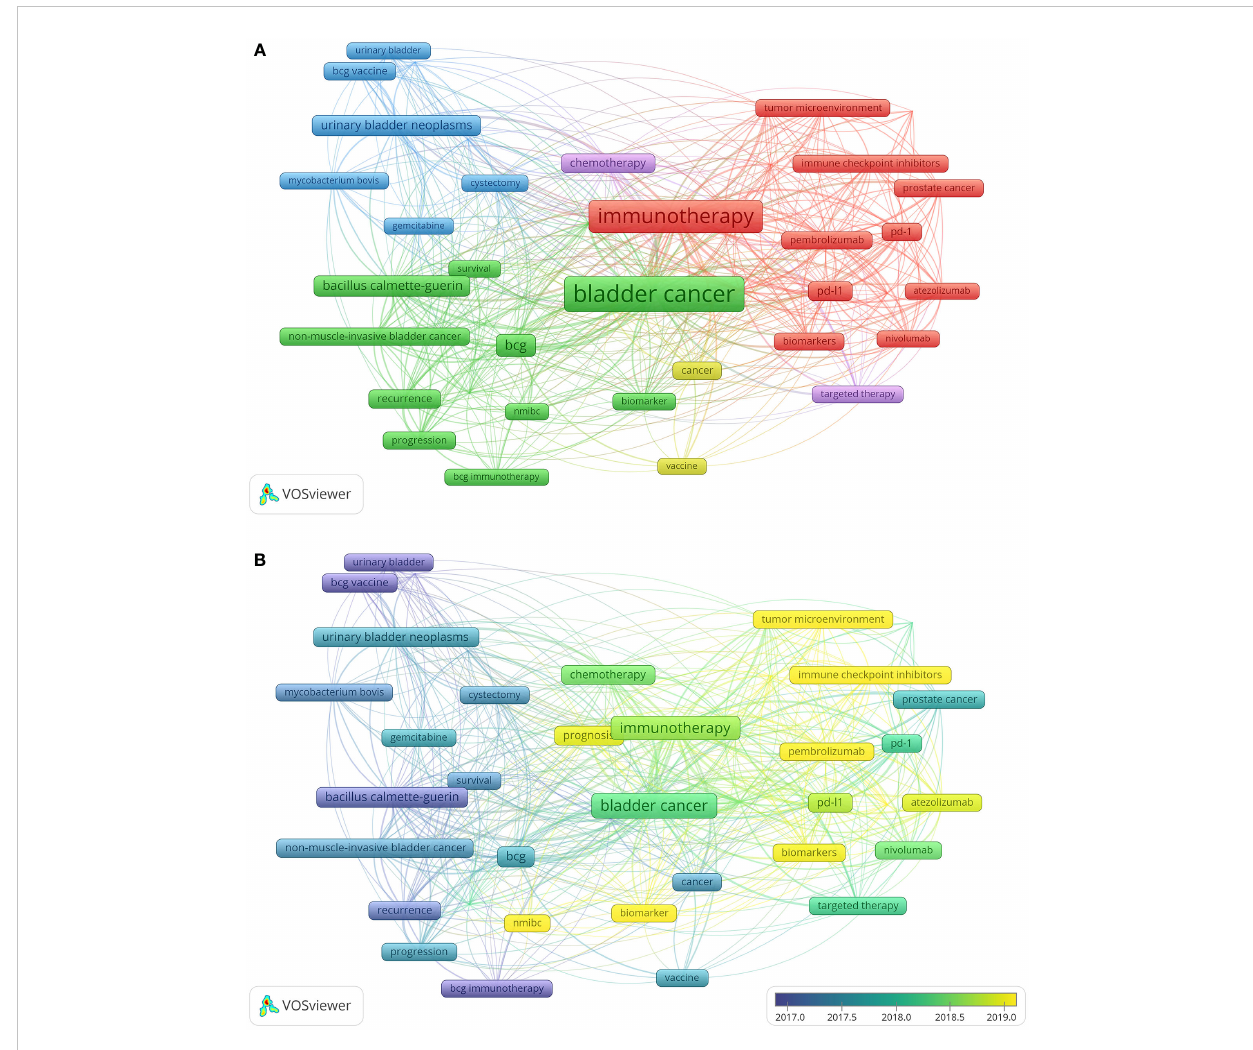
FIGURE 4 Visual map of the co-occurrence of keywords. (A) Keywords clustering chart. Each term ’ s node size is proportional to the number of occurrences, with larger nodes showing a higher keyword occurrence. A shorter gap between nodes shows a closer link between selected phrases. (B) Keywords yearly change chart. Keywords in blue represent their average year of publication in a previous era, whereas green represents high-frequency keywords in the middle of the study. On the other hand, keywords in light green or yellow signify freshly developing research